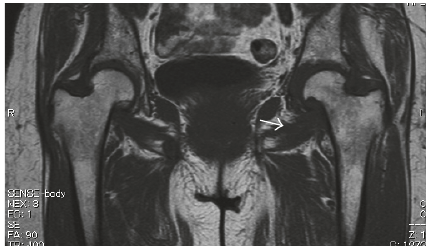
Figure 6: T1-weighted coronal magnetic resonance image at 1 month after surgery. There was no sign of avascular necrosis of the femoral head. The herniation sac had diminished in size (arrow).